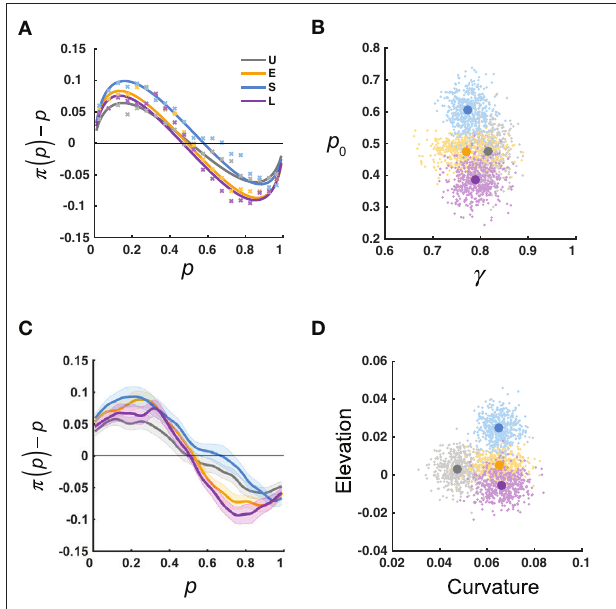
FIGURE 3 | Results: measures of probability distortion. U, E, S, L denote the p as a function of p : data (xs) vs. LLO four distribution conditions. (A) π ( p ) − model predictions (curves), averaged across participants for each condition. Each x denotes the mean estimate for a bin of p , with bin size of 0.05. (B) Slope ( γ ) and crossover point ( p 0 ) measures of probability distortion estimated using the LLO model. The variability of the estimated mean γ and p 0 is visualized by their bootstrap resamples, in clouds of dots. (C) Smoothed p as a function of the objective relative-frequency ( p ). The π ( p ) p π ( p ) − − curve was first smoothed for each participant and then averaged across participants for each distribution condition. Shadings denote 1 SE. (D) Curvature and elevation measures of probability distortion derived from the p curve of (C) The curvature measure is defined as the area between π ( p ) − the curve and the zero line, which is inversely related to the γ in LLO. The elevation measure is defined as the area of the curve above the zero line minus that below the zero line, which is related to the p 0 in LLO. The variability of the estimated mean curvature and elevation is visualized by their bootstrap resamples, in clouds of dots. The bootstrap procedure was as follows: for each condition and each pair of parametric or non-parametric measures, we randomly sampled with replacement for 16 times from the 16 participants and computed the means of the estimated measures for the resampled participants. This procedure was repeated for 500 times to generate the 500 resamples visualized in each